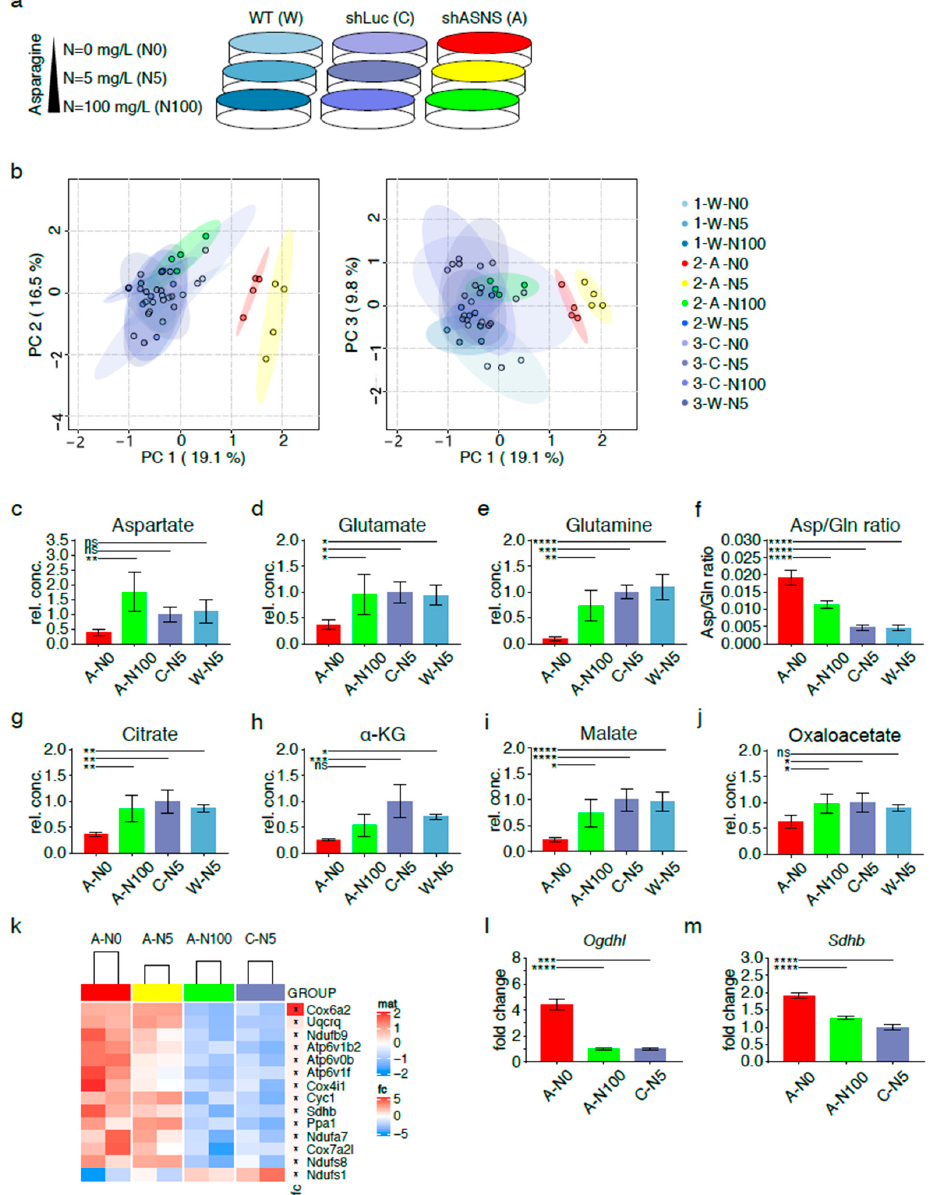
Figure 3. Metabolic adaptation of asparagine-deprived mouse sarcoma cells. ( a ) Asparagine availability was modified by exposing shASNS (A) sarcoma cells, shLuc control (C) sarcoma cells and wild-type (W) sarcoma cells to asparagine-free medium, medium containing near-physiological (5 mg/L) or supraphysiological asparagine concentrations (100 mg/L) for 2 days. Global metabolomic changes were investigated by GC-MS: samples were run in three independent experiments with four replicates per condition (experiment 1: 1-W-N0, 1-W-N5, 1-W-N100; experiment 2: 2-A-N0, 2-A-N5, 2-A-N100, 2-W-N5; experiment 3: 3-C-N0. 3-C-N5. 3-C-N100, 3-W-N5). Each of the three experiments included wild-type control cells grown at physiological asparagine concentrations (1-W-5, 2-W-N5, 3-W-N5). For each experiment, MS data from W-5 runs were averaged and then used to normalize MS data obtained for the other samples. ( b ) Principal component analyses highlighted global differences in the metabolome of shASNS cells cultured with 0 (2-A-N0; marked in red) or 5 mg/L (2-A-N5; marked in yellow) asparagine as opposed to shLuc and wild-type control cells (marked in shades of blue). After supplementation with 100 mg/L asparagine (2-A-N100, marked in green), shASNS cells clustered with shLuc and wild-type cells. Further analyses by LC-MS revealed that the metabolome of asparagine-deprived A-N0 sarcoma cells grown without supplemental asparagine was marked by ( c ) low aspartate, ( d ) glutamate and ( e ) glutamine levels compared to control C-N5 and W-N5 cells. ( f ) Higher aspartate/glutamine ratios suggest that glutamine is shunted towards aspartate synthesis in asparagine-deprived N0 cells. Reduced ( g ) citrate, ( h ) alpha-ketoglutarate and ( i ) malate levels in asparagine-starved